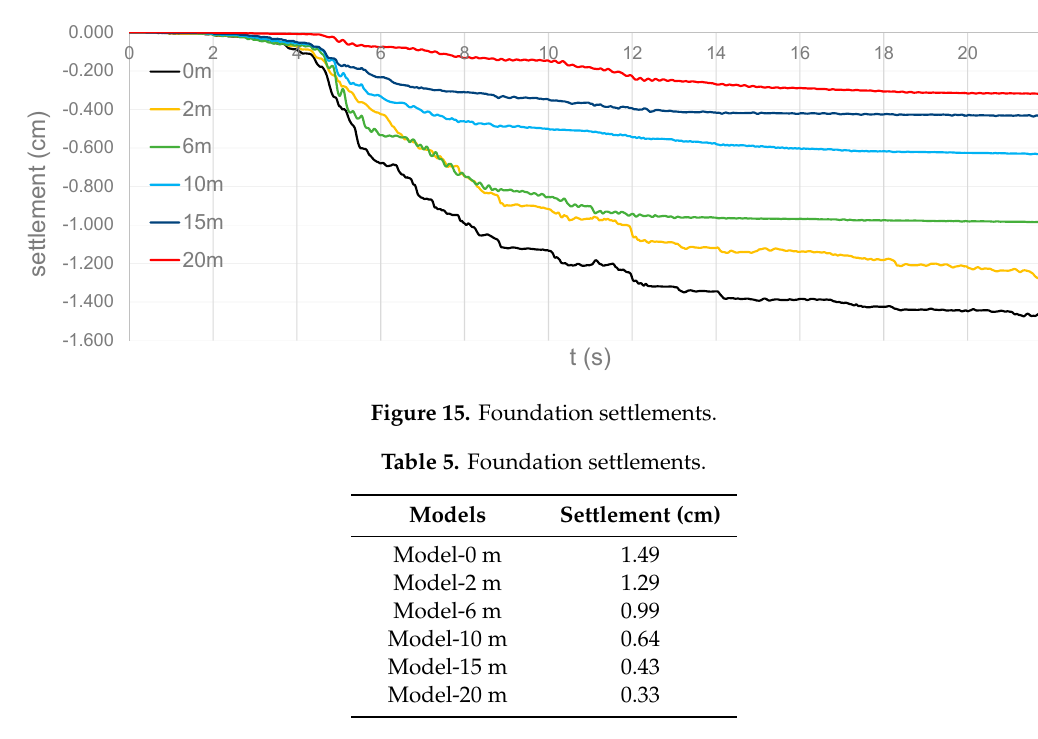
Figure 16. Foundation tilts. Table 5. Foundation settlements.